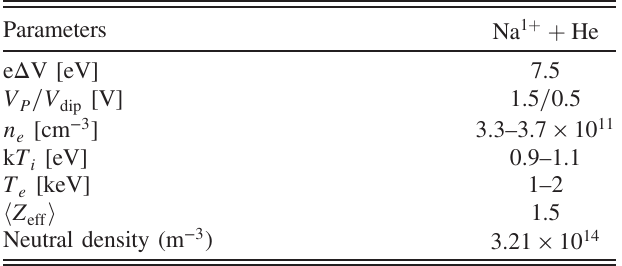
TABLE VI. Optimum plasma parameters obtained in second step.